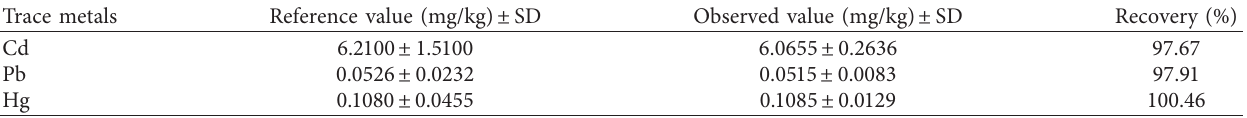
Table 2: Trace metal determination in proficiency tests (FAPAS canned fish samples).